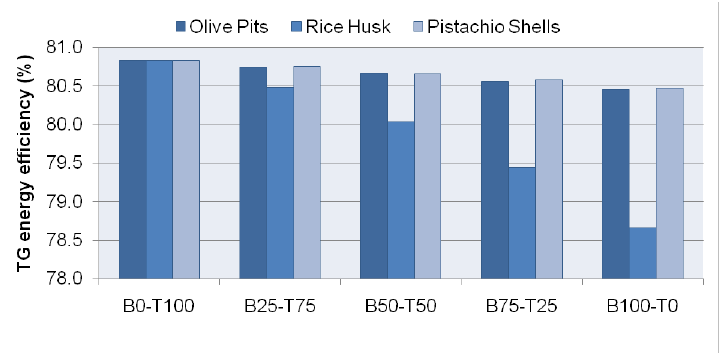
Fig. 3. Variation of the system energy efficiency with different blends of Tunçbilek coal and biomass types.